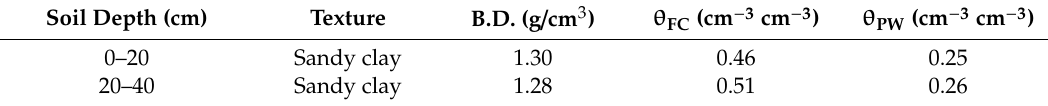
Table 2. Soil physical characteristics of the experimental area.